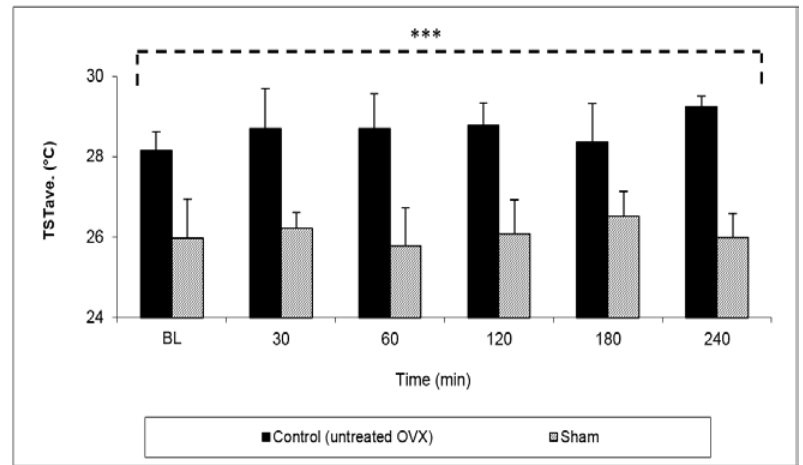
Figure 4. Tail skin temperature (TST) average values in untreated ovariectomized (OVX) Sprague–Dawley female rats and an untreated sham group. Data represent the mean ± SD, n = 8 for each group. *** p < 0.001 extremely significant by unpaired two-tailed t -test.